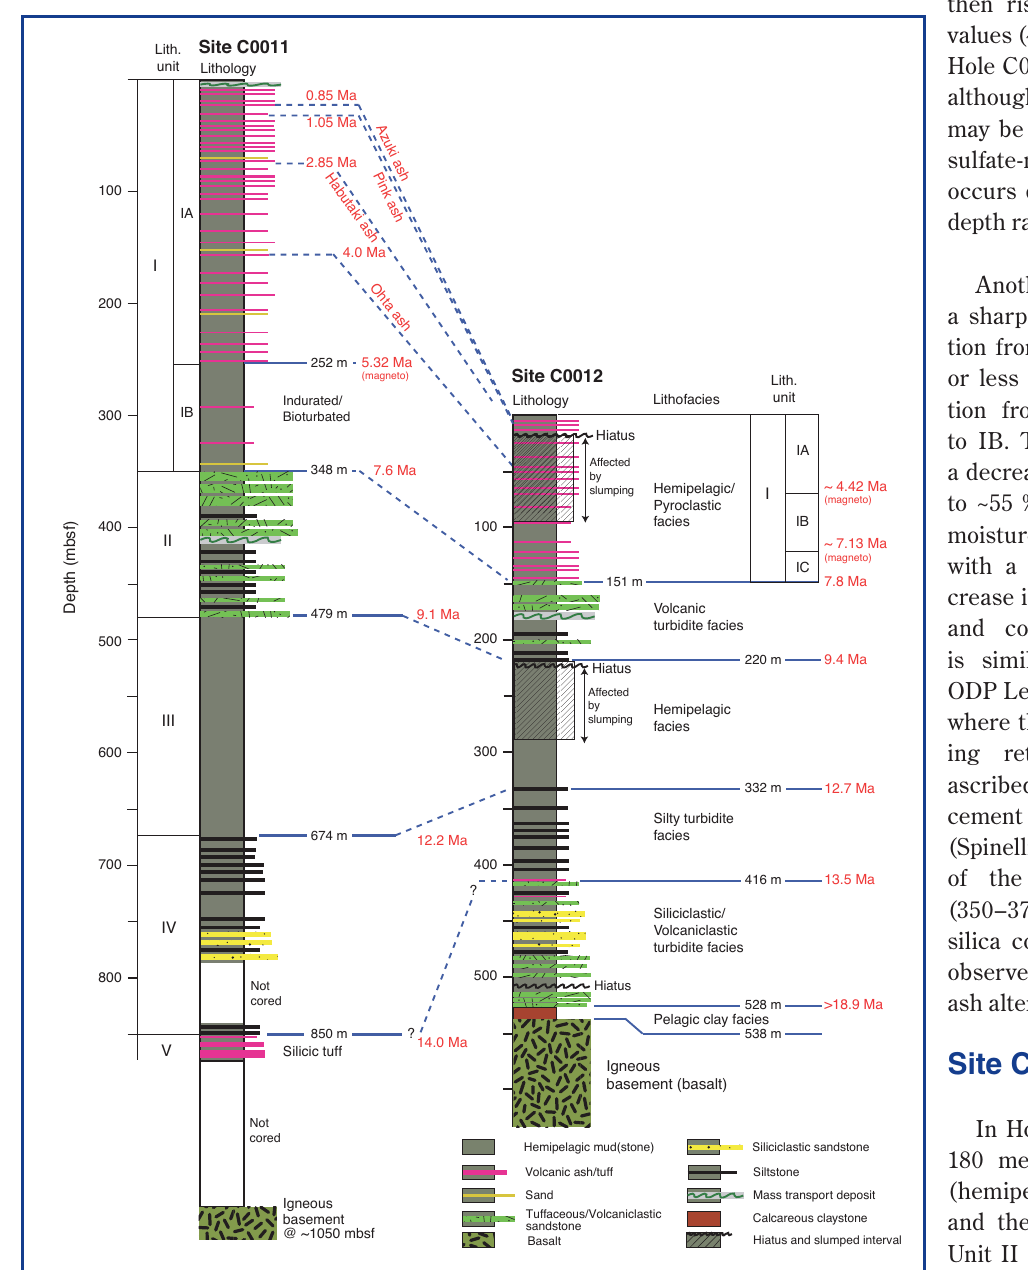
Figure 4. Stratigraphic correlation between Sites C0011 and C0012, based on composite lithology columns and age information from Expeditions 322 and 333. Unit boundary ages taken from integrated age-depth